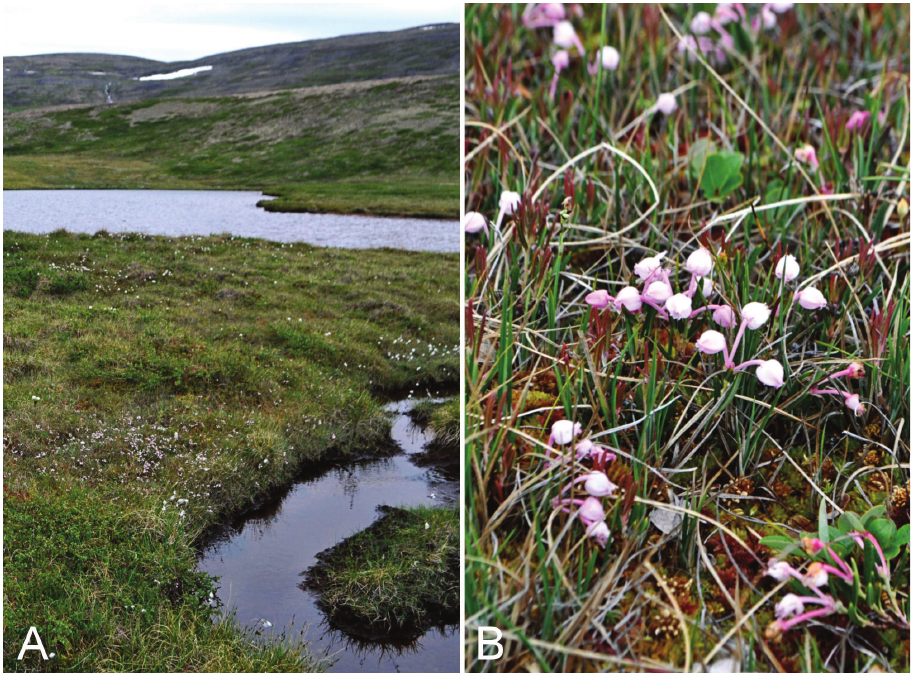
Figure 13. Andromeda polifolia : A habitat B habit, Saarela et al. 2186 . Photographs by P.C.